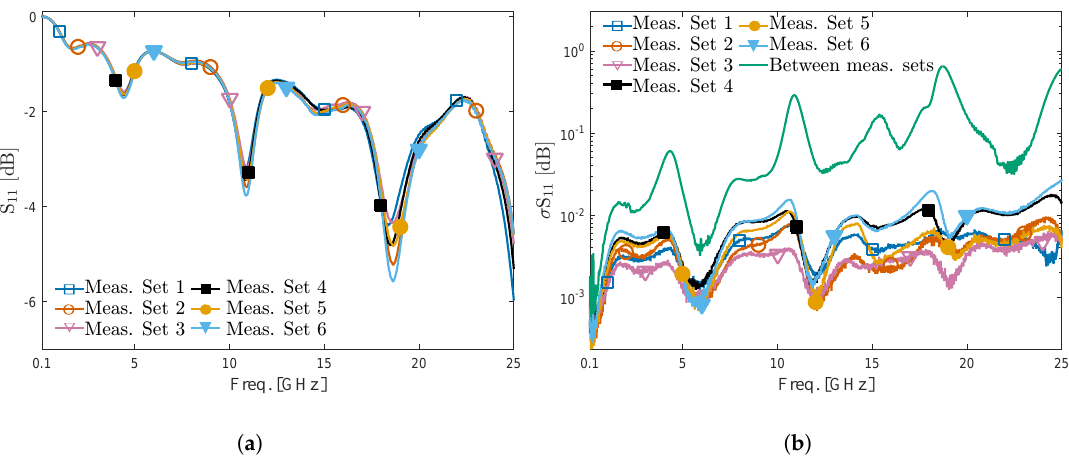
Figure 4. Measurement results of reflection coefficient (S 11 ) with consumable interdigital capacitor (IDC) sensors with the microfluidic channel loaded with air for different measurement sets. ( a ) Mean value for each measurement sets. ( b ) Standard deviation within the same measurement sets and between the mean value of different measurement